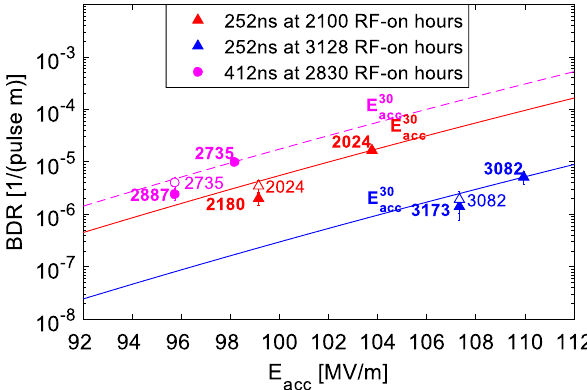
FIG. 9. BDR as a function of E (red at 2100 rf-on hours and blue at 3128 rf-on hours) and 412 ns (pink). The reference lines are E